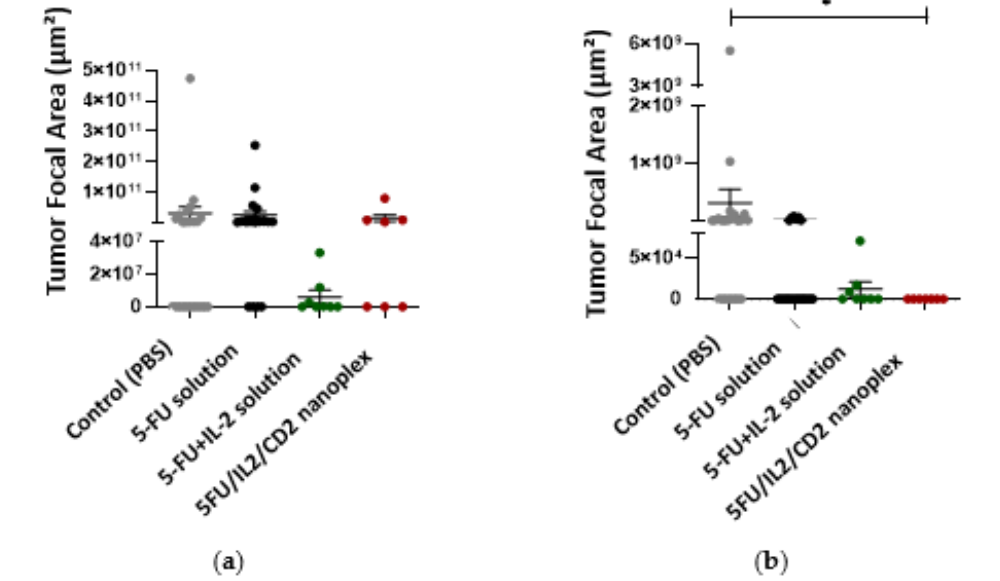
Figure 14. The metastatic areas (*) in liver ( a ), and lung ( b ), in treatment groups treated with PBS, 5-FU solution, 5-FU+IL-2 solution and 5FU/IL2/CD2 nanoplex (* p < 0.05).